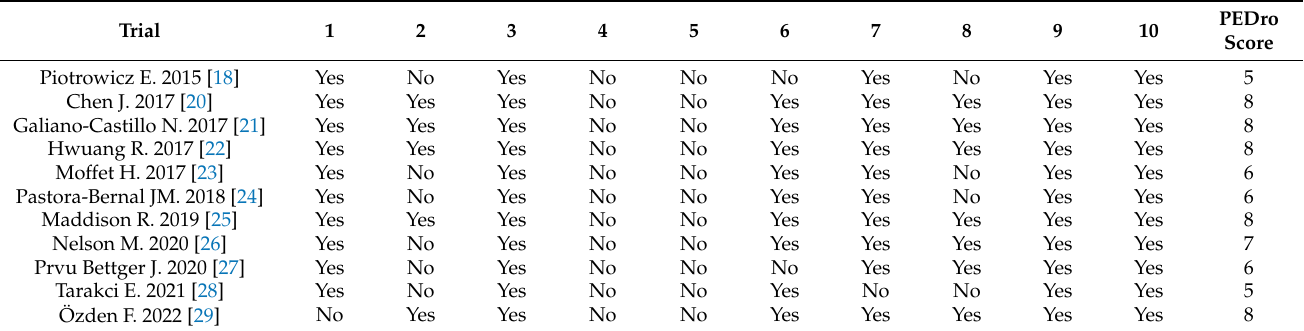
Table 3. Methodological quality